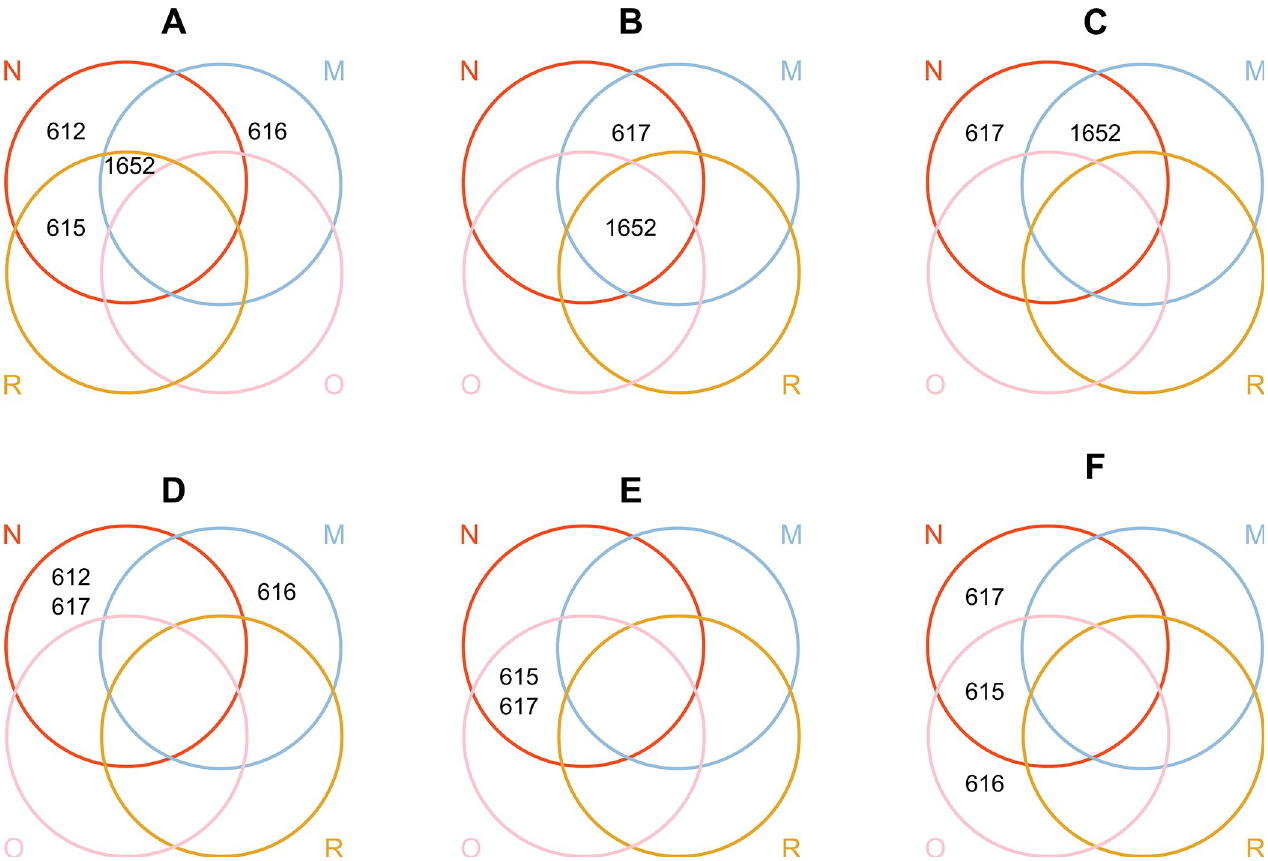
Fig 2. Visualisation of the herd distribution of group B Streptococcus sequence types (STs) isolated from different sampling sites in six camel herds (A-F) in Laikipia County, Kenya, November 2019. Colour of the rings and capital letters correspond to sampling sites; N = nasal swab (red), R = rectal swab (yellow), O = oral swab (pink), M = milk sample (blue). Note that the position of rings for herd A is modified to allow for visualisation of the data.